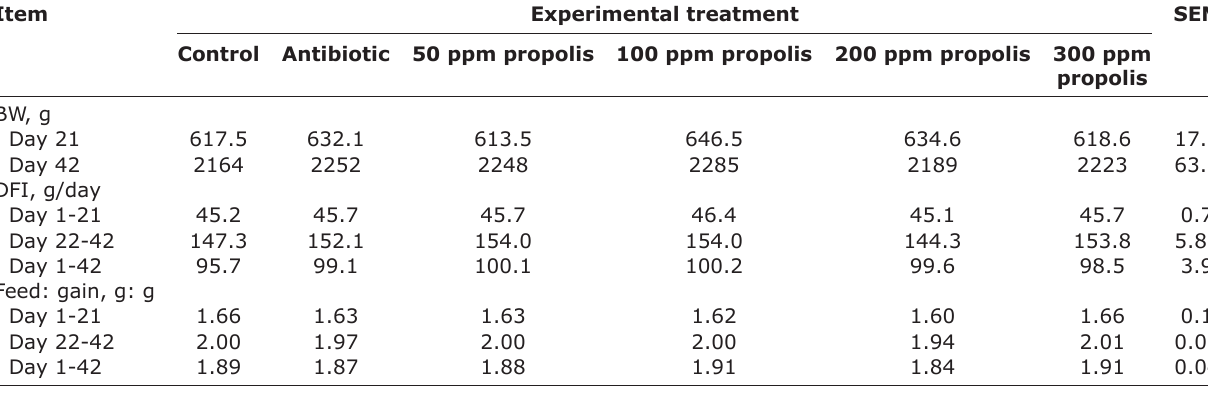
Table-2: Effect of experimental diets on performance indices of broilers at different ages. Item Experimental